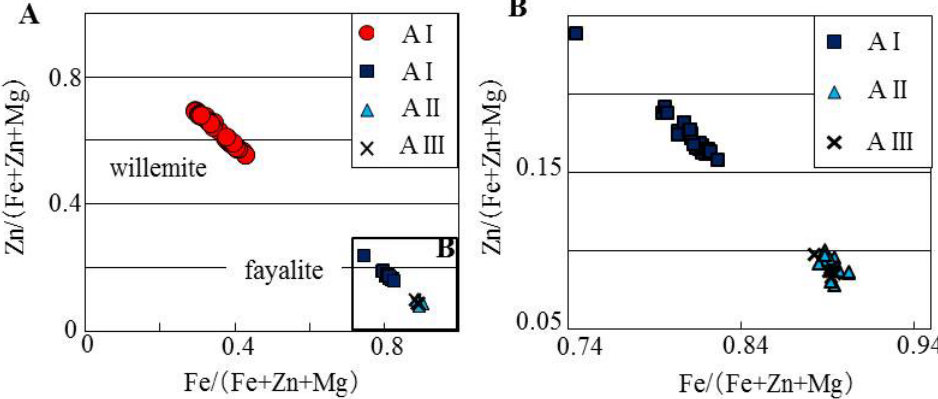
Figure 4. Scattered diagrams of Zn/Fe rate ( A ) in willemite and fayalite ( B ) in fayalite disaggregated by the assemblages. AI: assemblage I; AII: assemblage II; AIII: assemblage III.